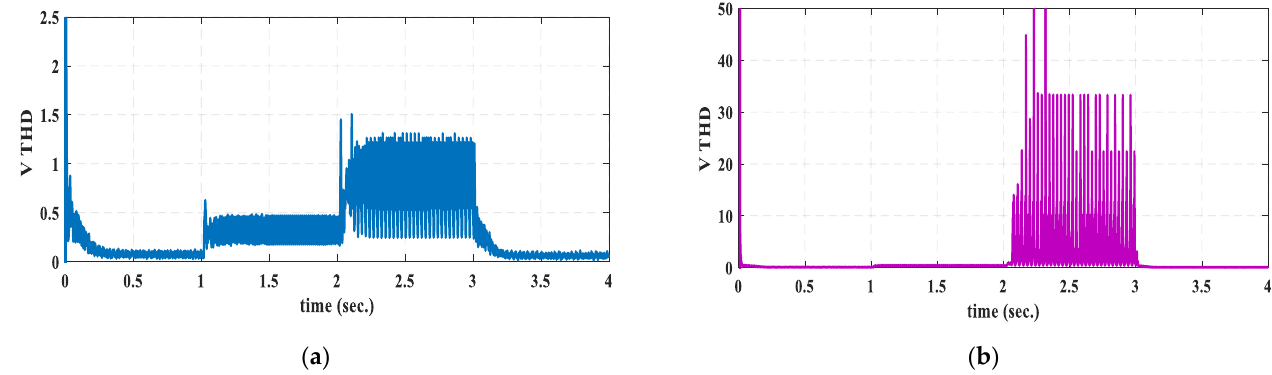
Figure 8. THD in voltage–time characteristics: ( a ) with 3-phase inverter and transformer( b ) with 6-phase inverter.